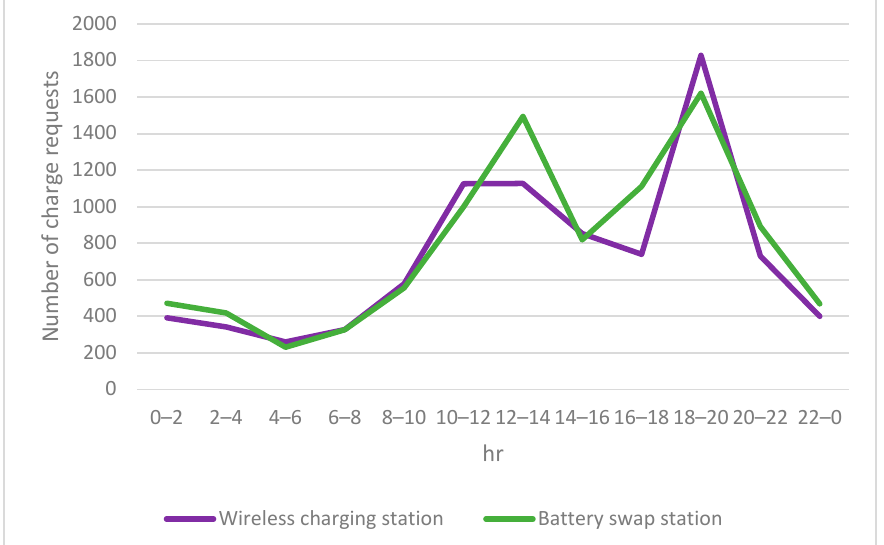
Figure 7. Number of charging requests for regular missions.